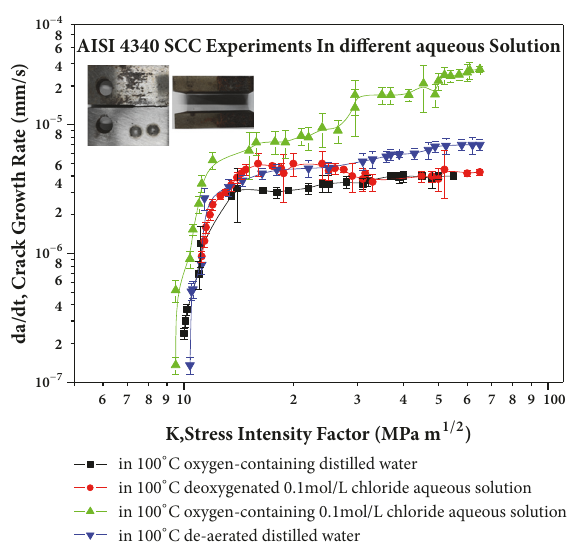
Figure 9: d 𝛼/ dt of 4340 steel in different aqueous